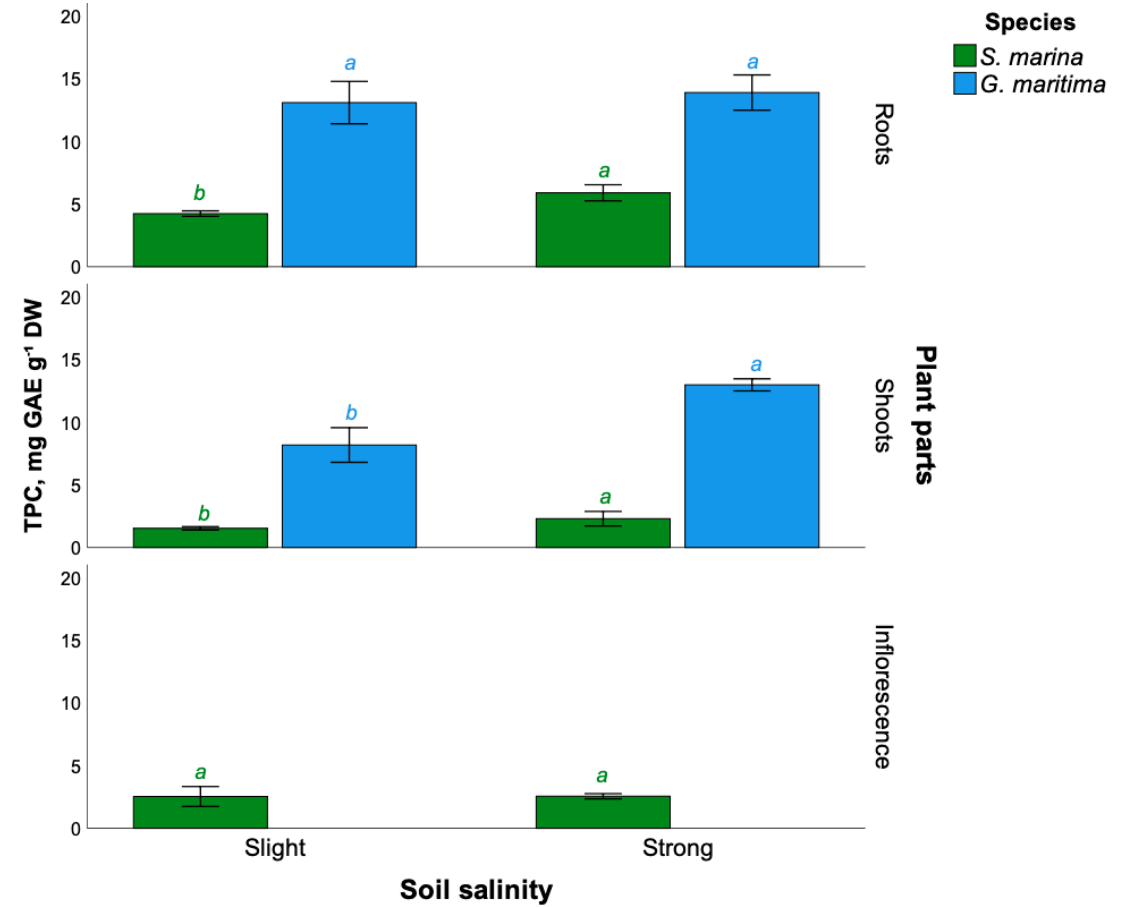
Figure 1. The total content of phenolic compounds in different parts of the studied plants of S. marina and G. maritima at different levels of soil salinization. Different letters indicate significant differences among the different levels of soil salinity ( t ‐ test, p ≤ 0.05).